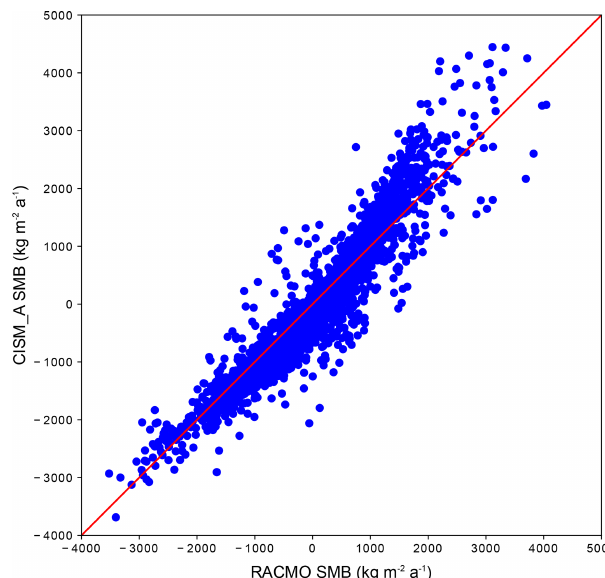
Figure 3. Scatter plot of all grid points of SMB for RACMO2.3 vs. CISM-A interpolated to the RACMO2.3 grid.